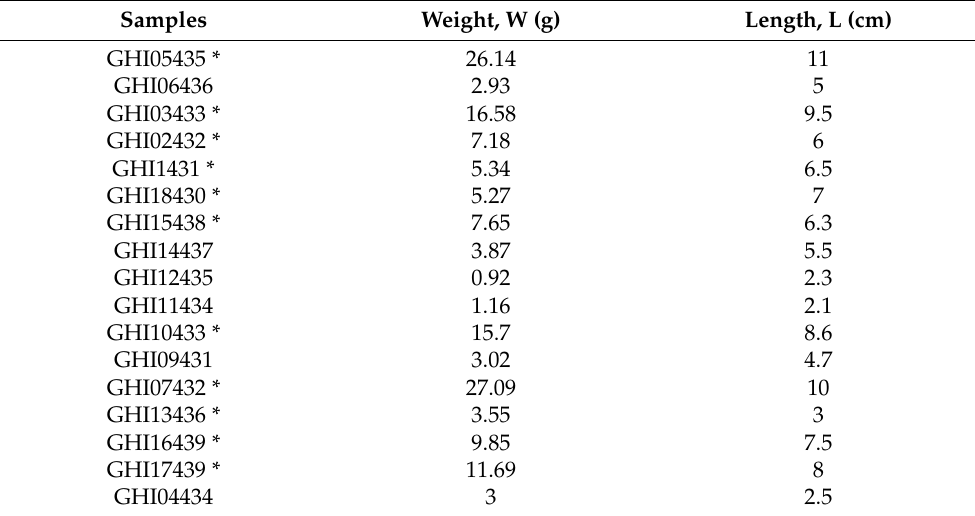
Table 3. Body weight without coelomic fluid (g) and the length (cm) of the samples of H. impatiens . ( * ) mature individuals with